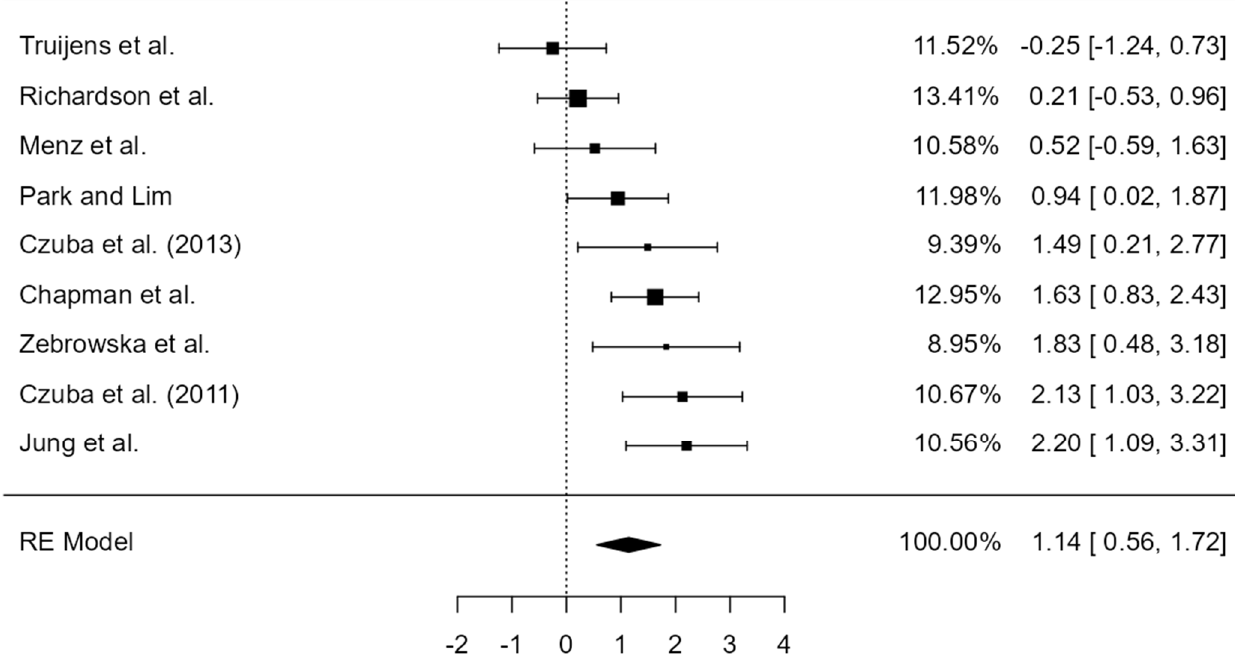
Figure 2. Summary of studies examining HIIT in hypoxia on VO 2max sorted by standardised mean difference (SMD). Data are presented as the percentage weight each study contributes to the pooled SMD, individual SMD [95% CIs]. Note that symbol size of individual studies is representative of the weighting for the pooled standardised mean difference. The filled diamond indicates overall SMD. RE = random effects [44–52].